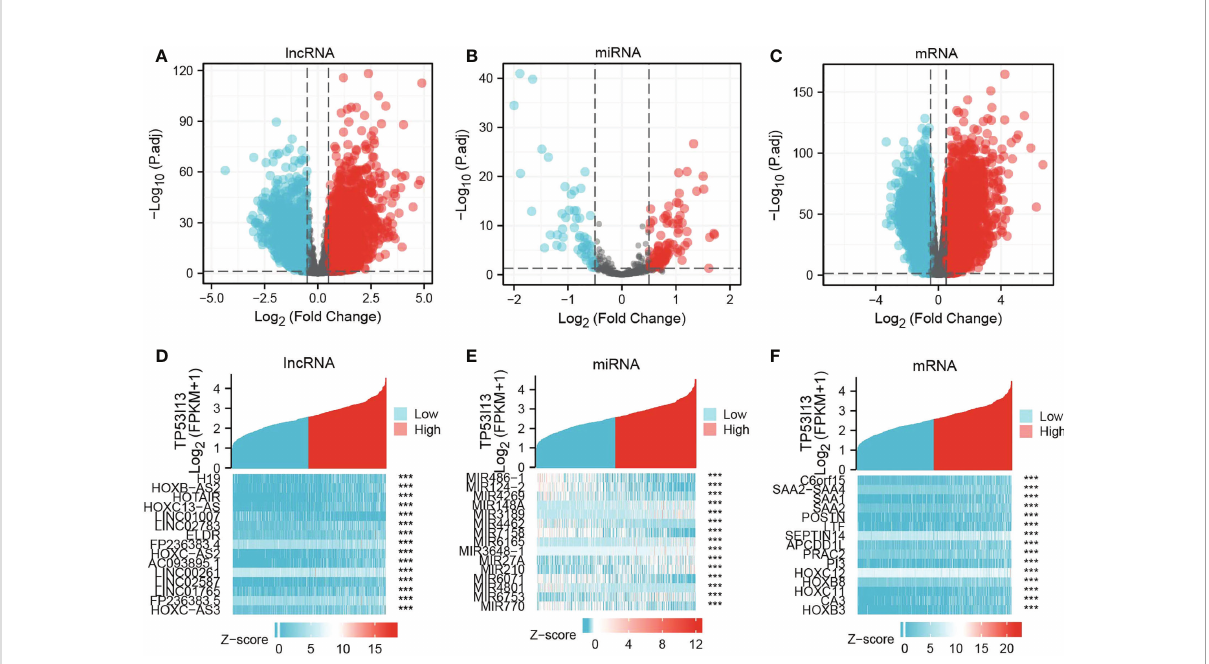
FIGURE 6 Volcano plots and heatmaps of DElncRNAs, DEmiRNAs, and DEmRNAs in glioma samples with low and high TP53I13 expression levels. The volcano plots illustrate the (A) DElncRNAs, (B) DEmiRNAs, and (C) DEmRNAs. Heatmaps of 15 signi fi cant Differentially expressed genes (DEGs) closely correlated with (D) DElncRNAs, (E) DEmiRNAs, and (F)